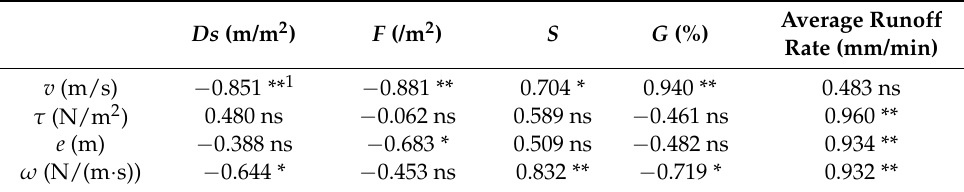
Table 2. Correlations between characteristic parameters of the drainage network (median values of the drainage density ( Ds ), stream frequency ( F ), stream sinuosity ( S ), and stream gradient ( G )) and hydrodynamic parameters (mean flow velocity ( v ), shear stress ( τ ), unit energy of water-carrying section ( e ), and stream power ( ω )). Ds (m/m 2 ) F (/m 2 ) S G (%)